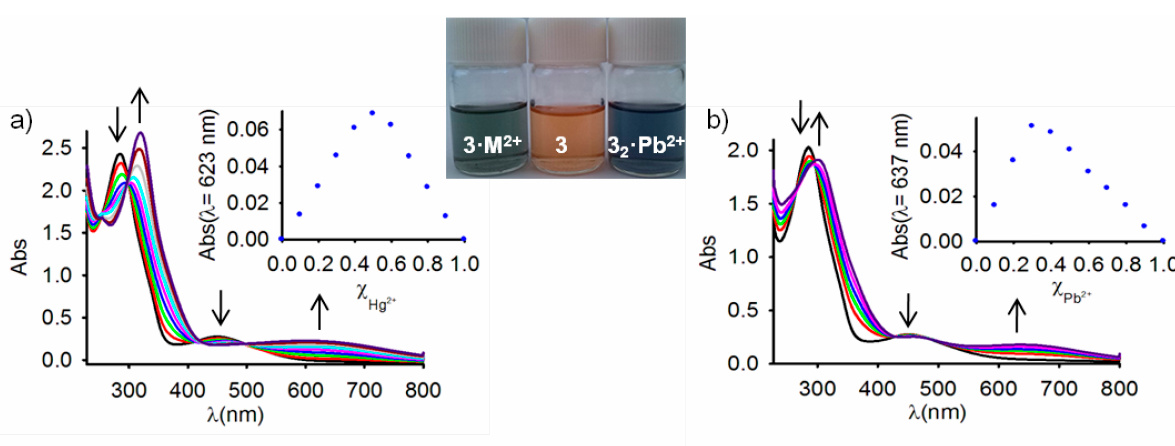
Figure 2. Evolution of the Uv-vis spectrum of 3 (c = 5 ⋅ × 10 − 5 M, in CH of increasing amounts of ( a ) Hg 2+ , and ( b ) Pb 2+ (c = 2.5 ⋅ × 10 − 2 M in CH The arrows indicate the absorptions that increase or decrease during the experiment. Inset: Job’s plots showing the 1:2 and 1:1 (M +2 /receptor) stoichiometries for the complexes formed with Pb 2+ and Hg 2+ ,